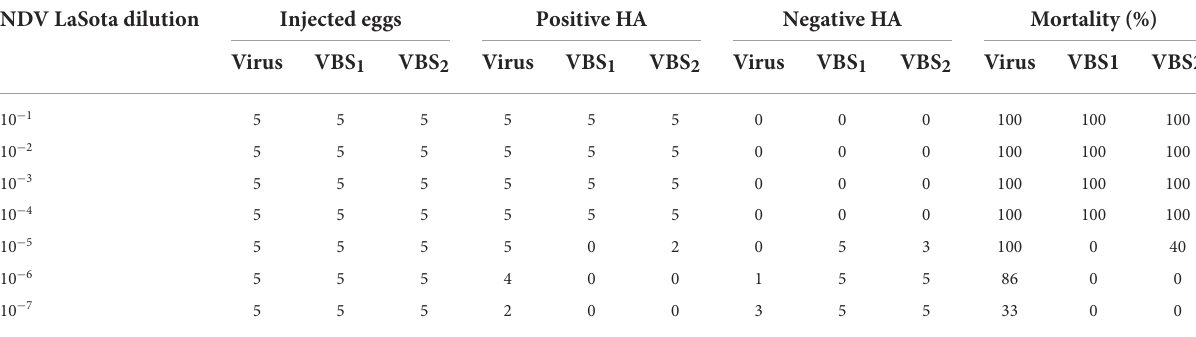
TABLE 6 Median percent embryo infectious dose of NDV LaSota strain treated by BS 1 and BS 2 solutions. NDV LaSota dilution Injected